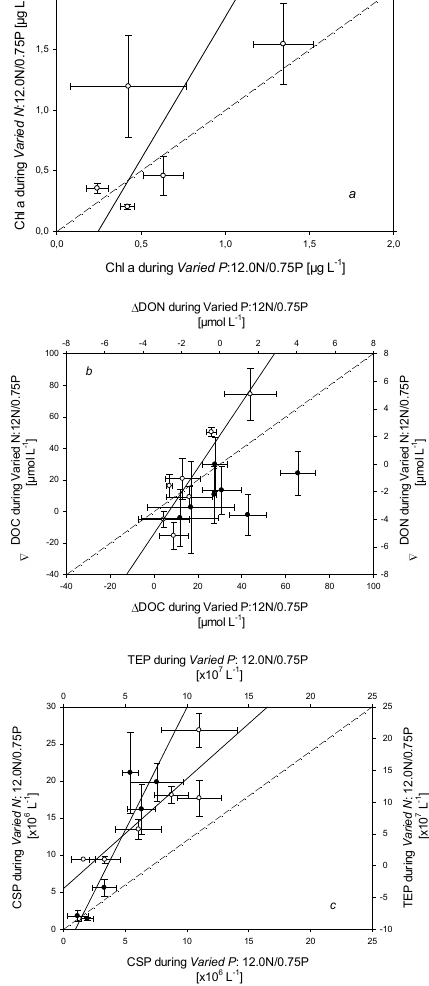
Figure 9. Comparison of Chl a concentration (a) , accumulation of DOC ( b , open symbols) and DON ( b , solid symbols), and abundance of TEP ( c , open symbols) and CSP ( c , solid sym- bols) observed in the course of the two mesocosm experiments for the treatment 12.0N / 0.75P. Direct relationships ([ y Varied N ] = a [ × Varied P ] + b ) were observed for Chl a , with a = 2.3 ± 0.2, r 2 = 0.94, n = 8; DOC with a = 2.1 ± 0.4, r 2 = 0.84, n = 8; TEP with a = 1.7 ± 0.4, r 2 = 0.78, n = 6; and CSP with a = 3.3 ± 0.7, r 2 = 0.86, n = 6. Symbols represent mean values of three meso- cosms ( Varied P ) or four mesocosms ( Varied N ) with ± 1 standard deviation (error